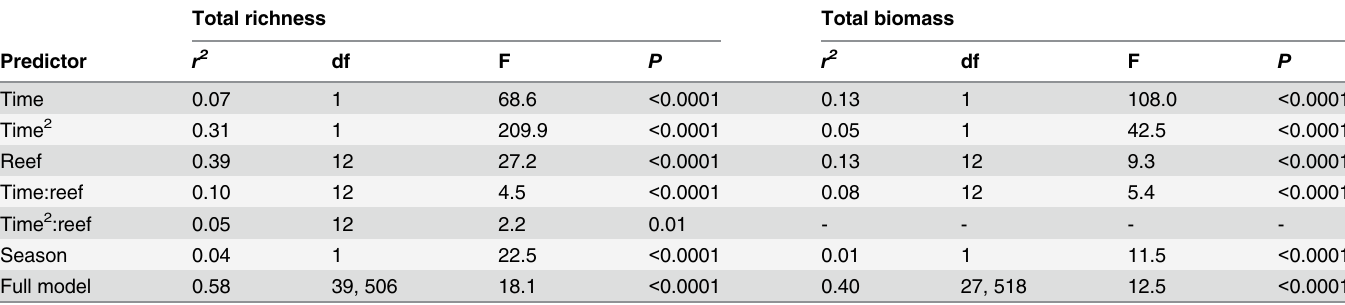
Table 1. Results of multiple regression analyses modeling total fish richness and total fish biomass. Only the significant predictors are shown, along with their partial coefficients of determination ( r 2 ). The time 2 :reef interaction was eliminated from the total biomass model by stepwise selection.